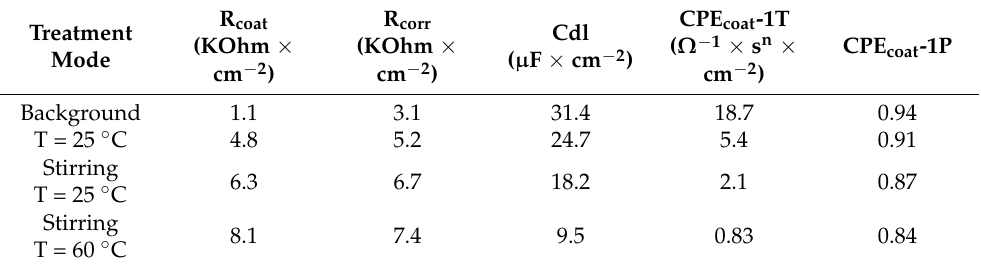
Table 4. Parameters of the equivalent scheme for steel samples after holding them in IDs at various exposure modes.